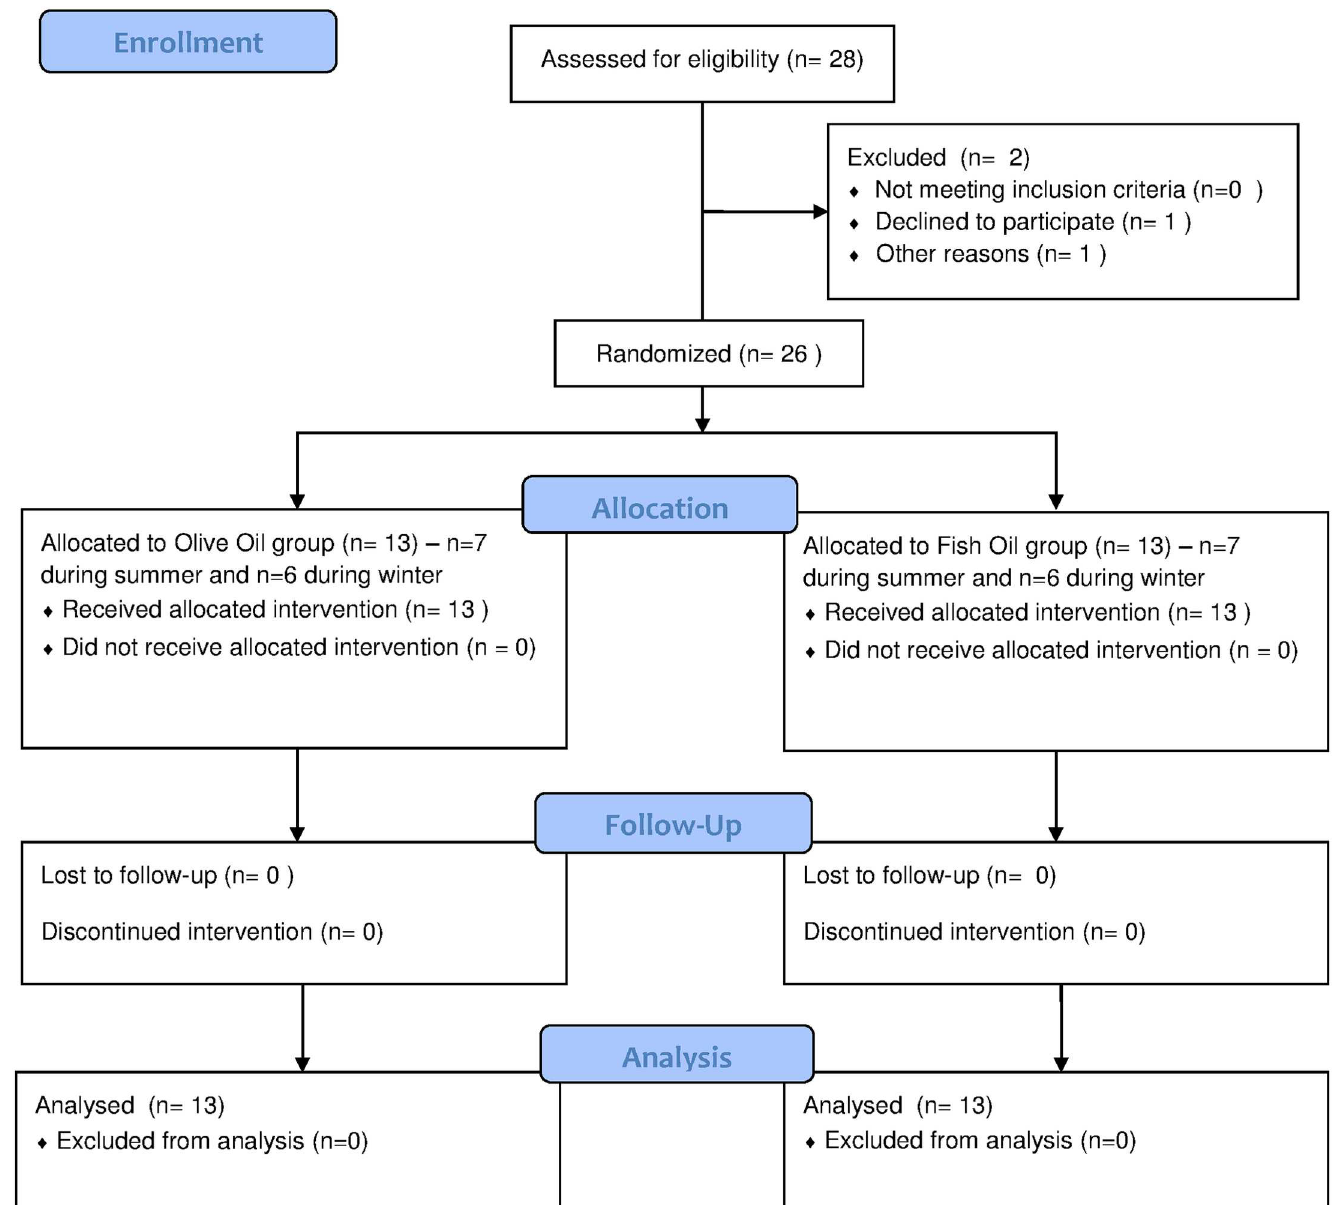
Fig 1. Consort figure illustrating participant flow through the